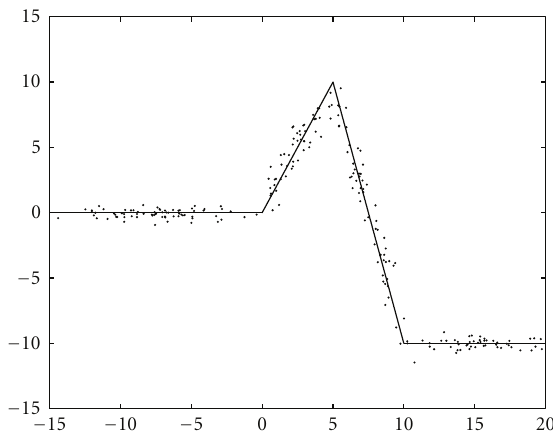
Figure 2: Training set associated with the toy function (17), repre- sented by the continuous